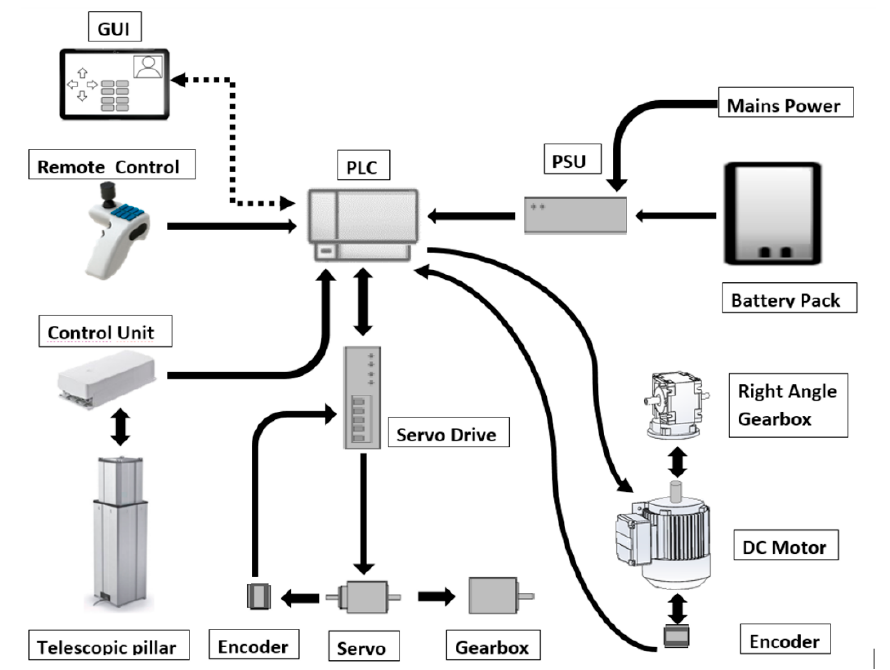
Figure 8. Component connections diagram.